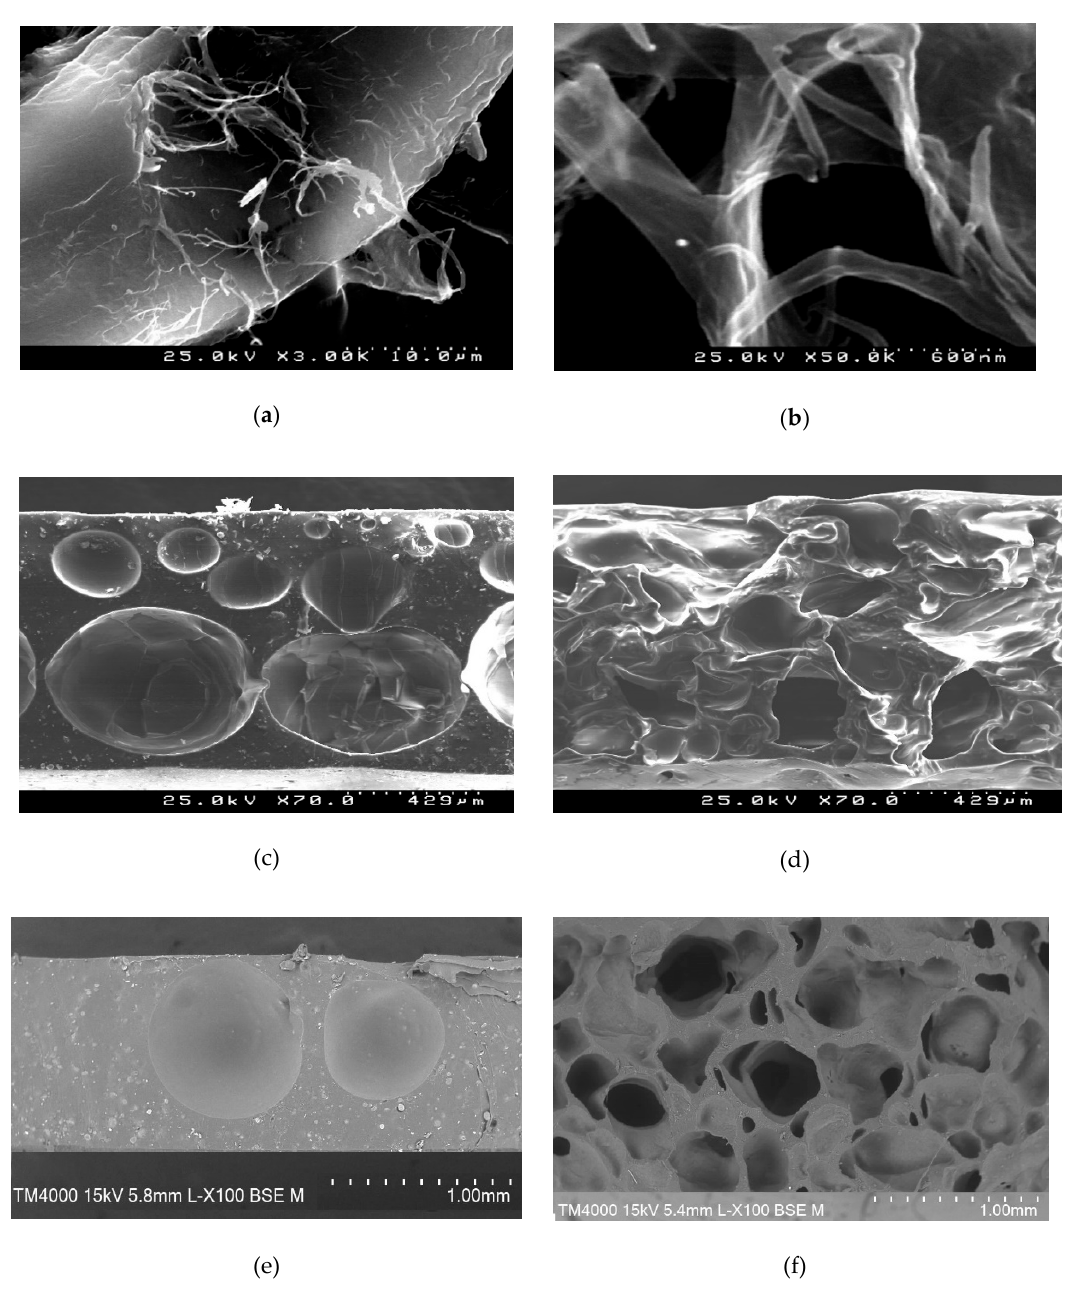
Figure 3. SEM images of: ( a ) and ( b ) LignoBoost ® kraft lignin mixture with MWCNTs (1%); ( c ) undoped LignoBoost ® kraft lignin-based polyurethane; ( d ) lignin-based polyurethane doped with 1.4% (w/w) of MWCNTs; ( e ) undoped ellagic acid-based polyurethane; ( f ) ellagic acid-based polyurethane doped with 1.4% (w/w) of MWCNTs.